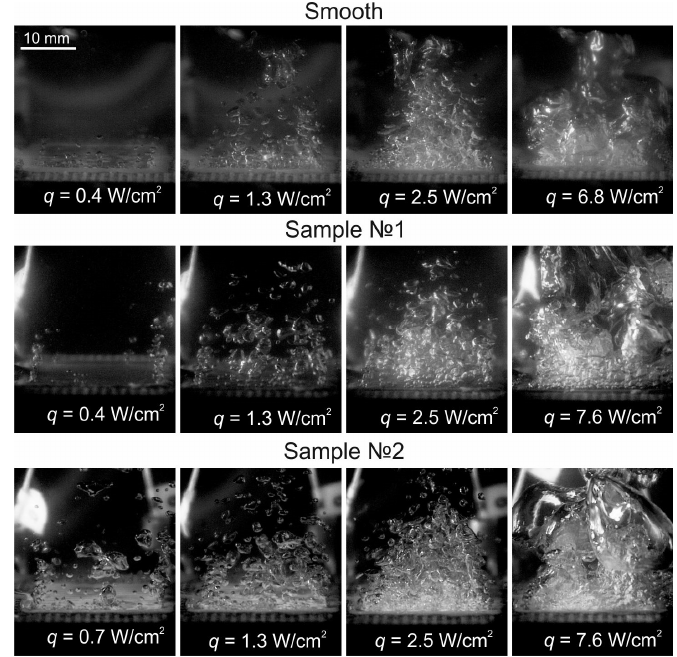
Figure 8. Boiling process at 0.017 MPa.